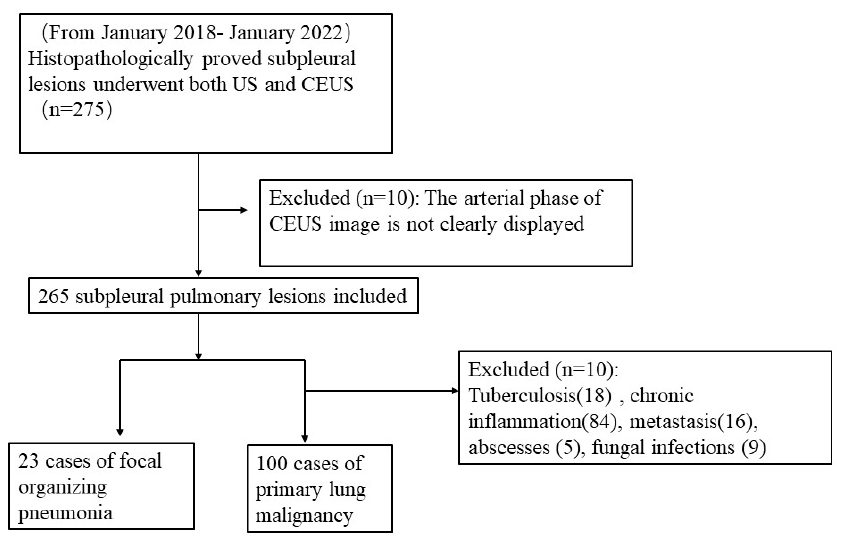
Figure 1. Flowchart of inclusion and exclusion criteria for focal organizing pneumonia and primary lung malignancy. (US: ultrasound; CEUS: contrast-enhanced ultrasound).